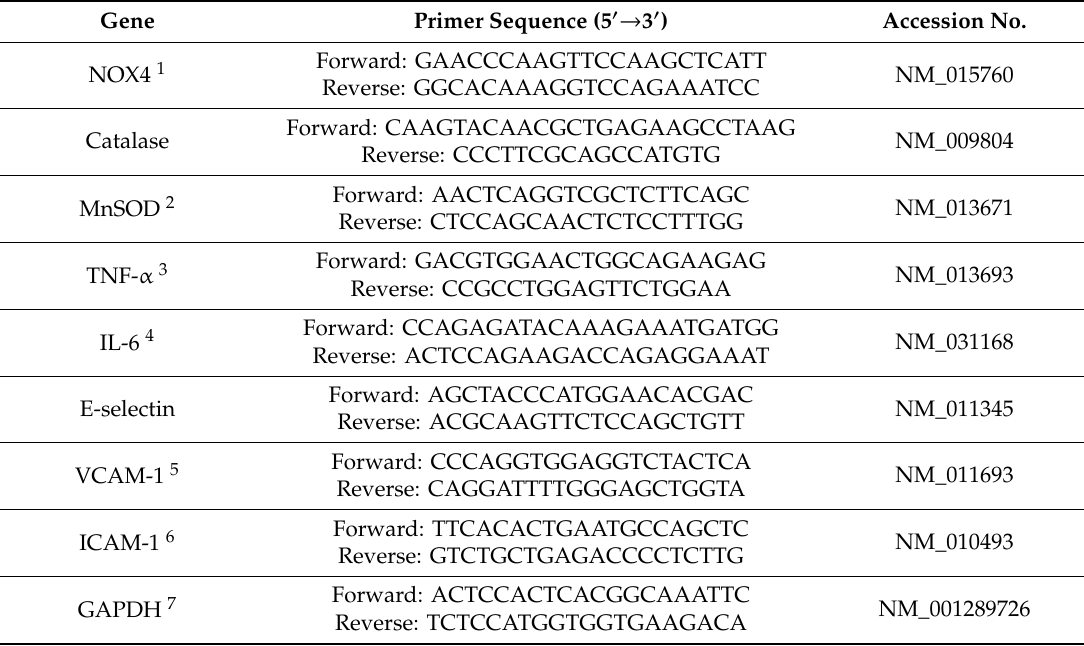
Table 1. List of primers used in this